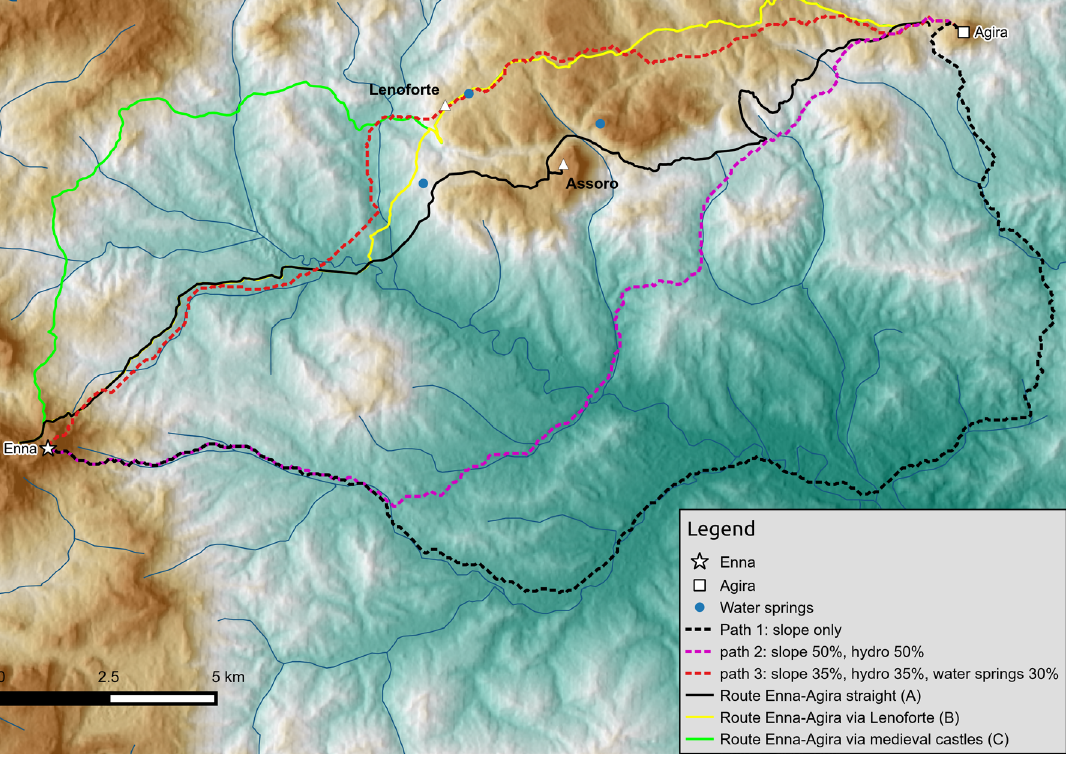
Fig. 4. Historical and evaluated paths